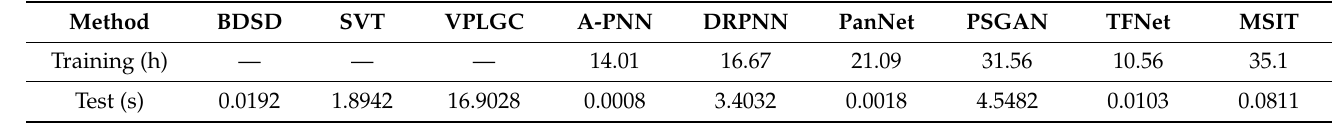
Table 9. Training and test times of different